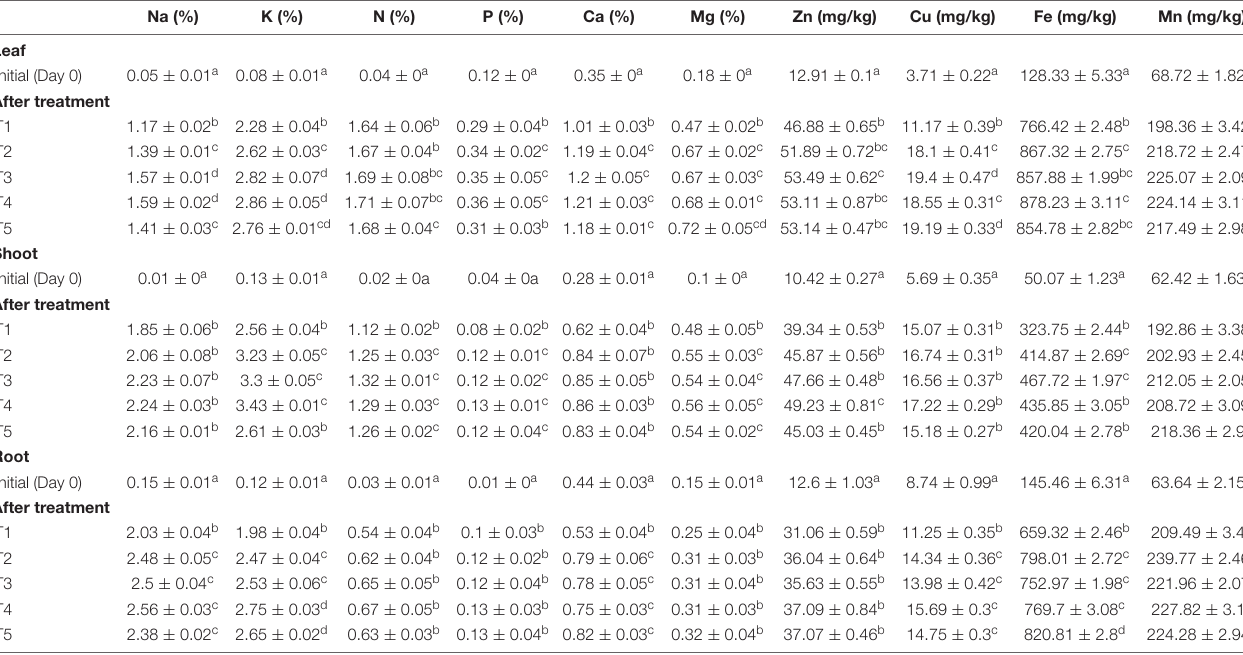
TABLE 9 | Macro and micro nutrient content of Eucalyptus Camaldulensis plants before and after